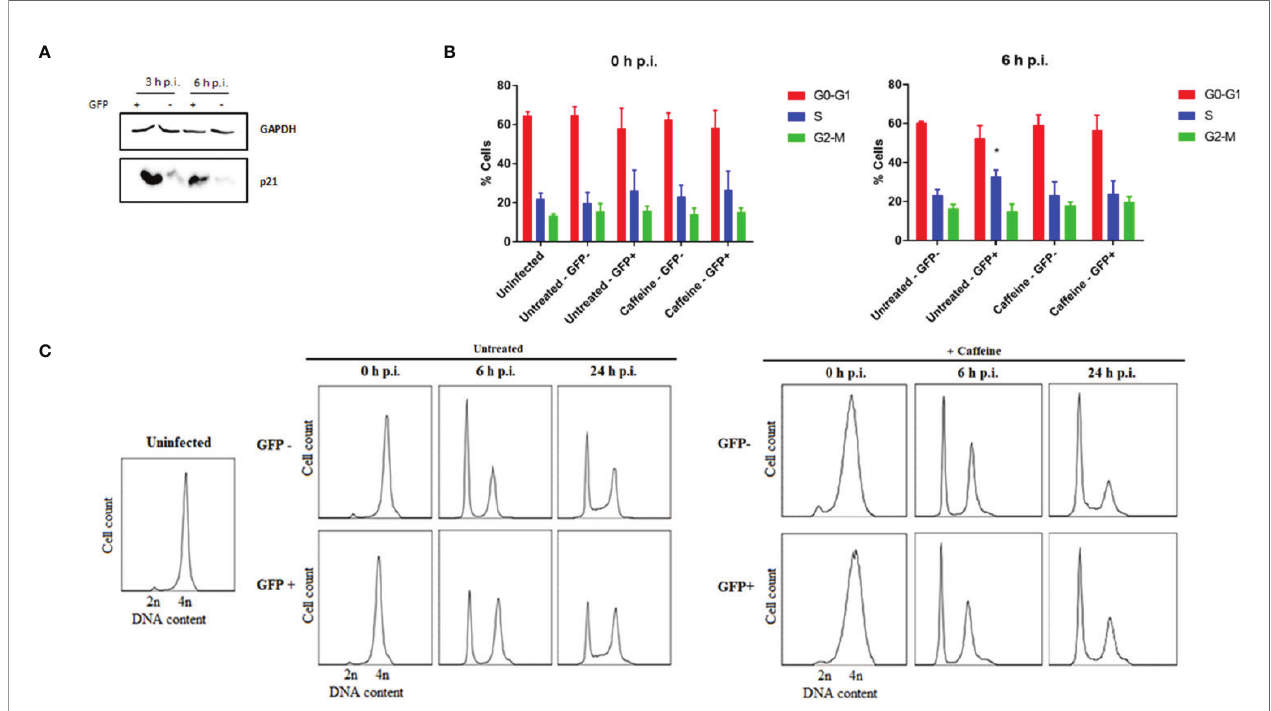
FIGURE 6 | Rck-mediated host cell alteration is a consequence of a DNA damage checkpoint response. HCT116 cells were infected with MC-RckGFP strain for 1 h with a MOI of 100. (A) Representative images of immunoblotting analysis corresponding to GAPDH as a protein loading control and p21 expression level of sorted GFP − and GFP+ infected cells at 3 and 6 h p.i. (B) DNA histograms generated at 0 and 6 h p.i. of sorted GFP and GFP+ infected cells maintained in the presence of caffeine for 6 h. Results are means ± SD from three independent experiments. Data were compared using a Mann-Whitney test (*p < 0.05; Untreated vs. Caffeine). (C) HCT116 cells were treated with RO-3306 for 24 h for G2/M synchronization, then infected with MC-RckGFP strain for 30 min at a MOI of 100. The cells were maintained in the presence or absence of caffeine for 0, 6 and 24 h p.i. GFP+ and GFP − cell populations were sorted by fl ow cytometry and cell cycle analysis was